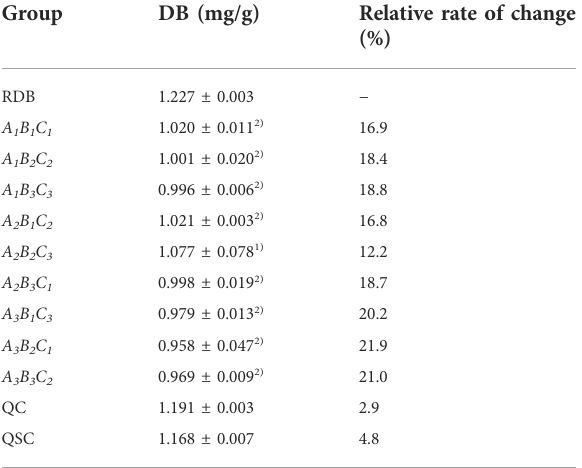
TABLE 2 Determination of DB content in 95% ethanol extracts of RDB and processed products of ASR-processed RDB. Group DB (mg/g) Relative rate of change (%)